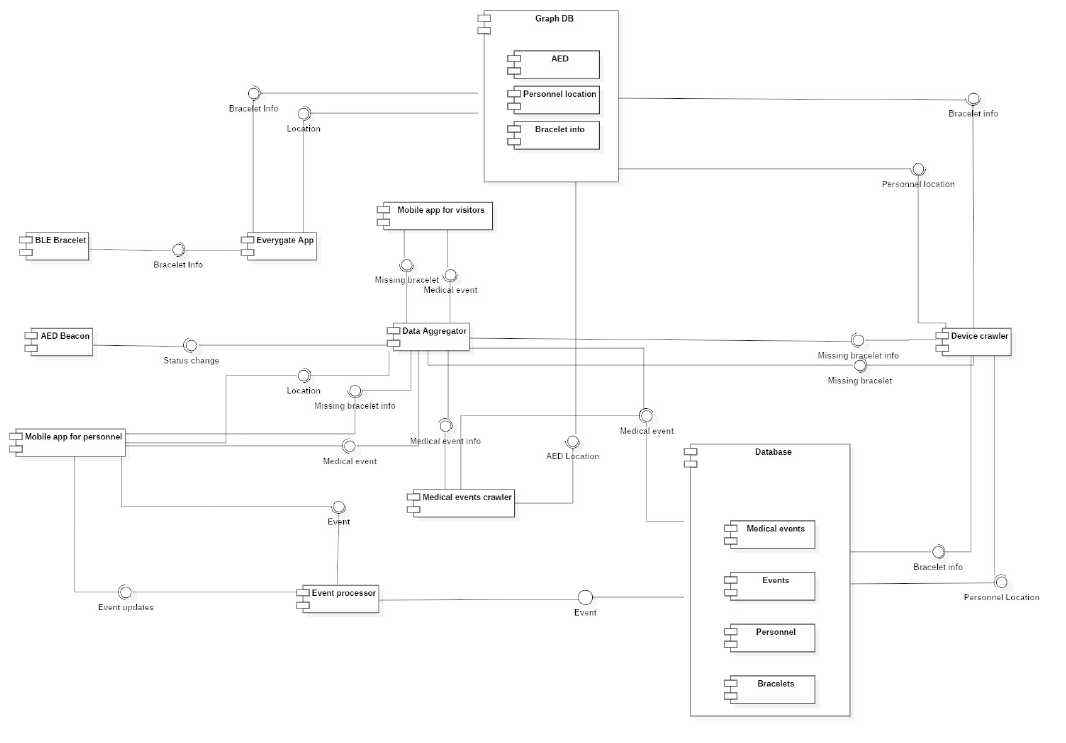
Figure 1. DESMOS system